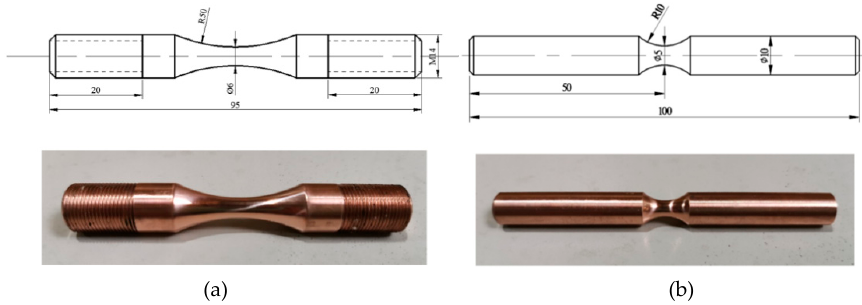
Figure 2. Specimens and dimensions in millimetres: ( a ) TC specimen; ( b ) RB specimen.